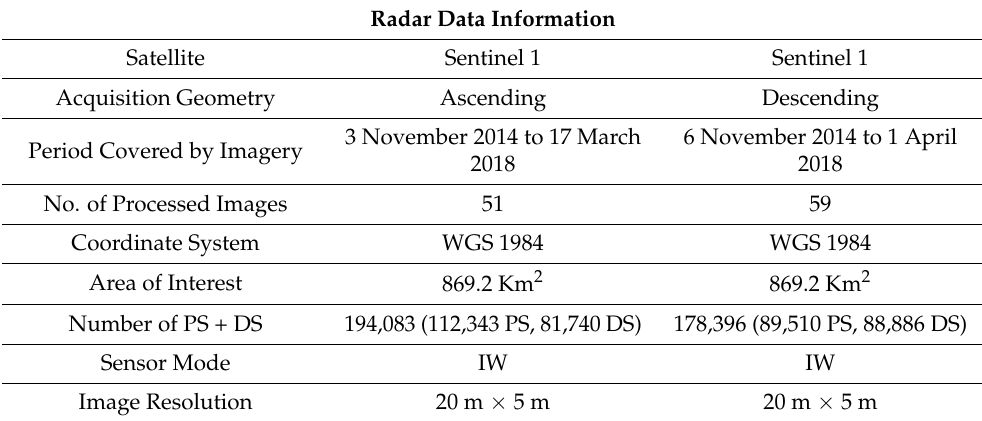
Table 2. Details of the processed satellite InSAR